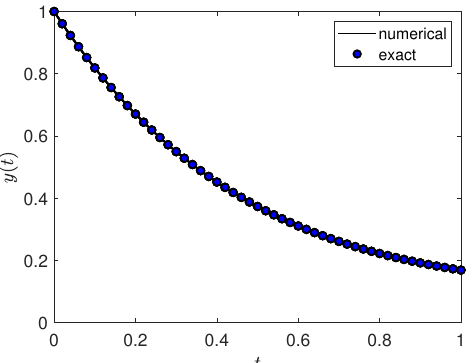
Figure 8. Graphs of the exact and approximate solutions for example